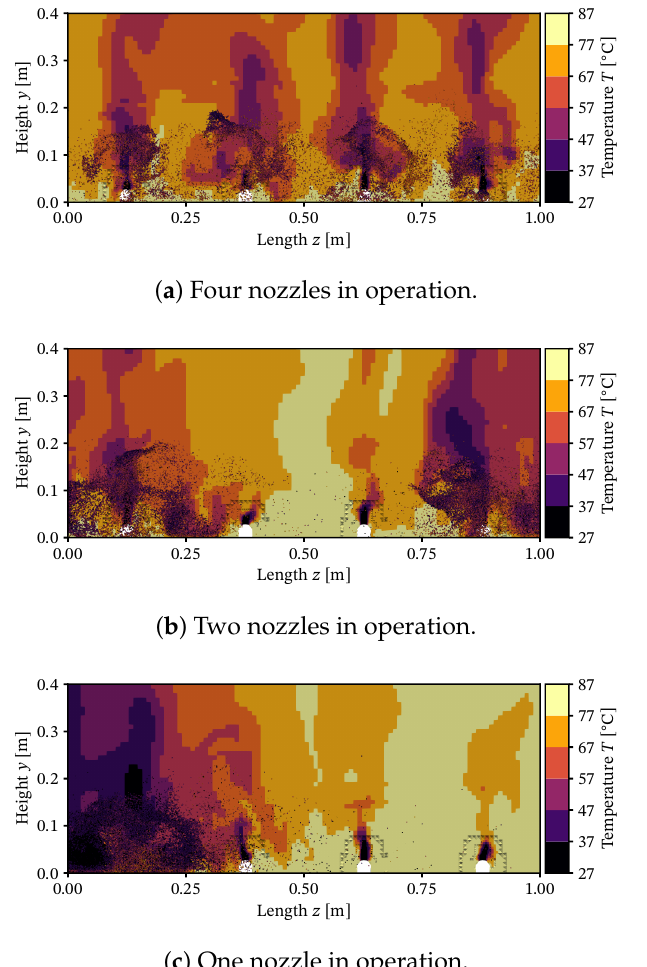
Figure 14. Particle and gas phase temperatures in the GF25 plant (spray rate ˙ M spray = 8 20gmin − 1 ) after a 60s process when introducing the same amount of liquid through one × (on the very left), two (the outermost) or all four nozzles. Only wetted particles are shown and colored according to their temperature.